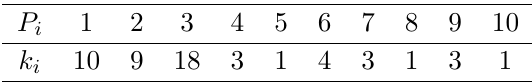
must i . The ideals P i are given − ++